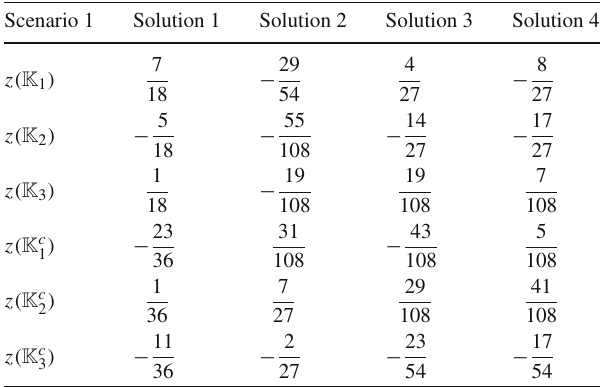
Table 18 The same as in Table 17, but with the minimal number of singlets under the SM gauge group n ν c = 4 , n S = 3 and n N =